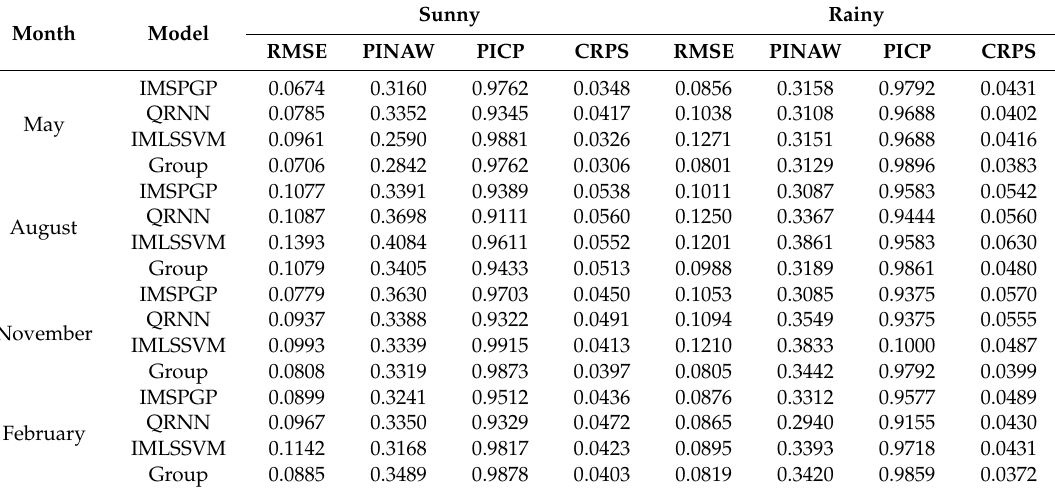
Table 9. Evaluation indices of di ff erent models during four